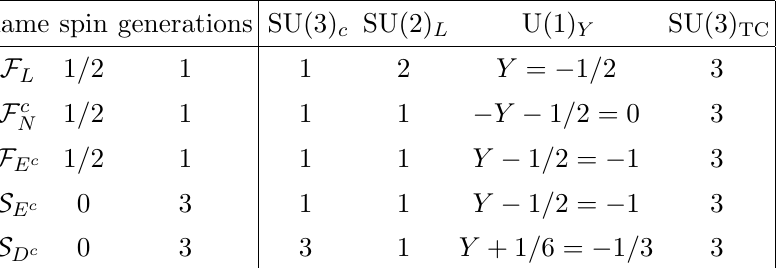
Table 4 . Field content of the simplest Fundamental Composite Higgs model. Extra fermions c ; ; c with conjugated gauge quantum numbers such that the fermion content is vectorial N F F L F E are implicit. Names are appropriate assuming the value Y = however generic values are